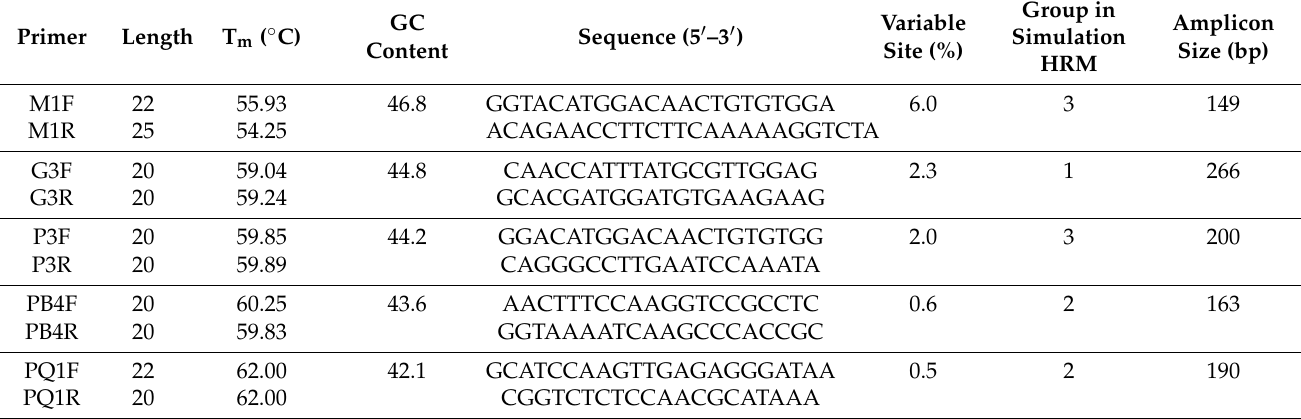
Table 4. Details of the candidate primers from manual design and web-based